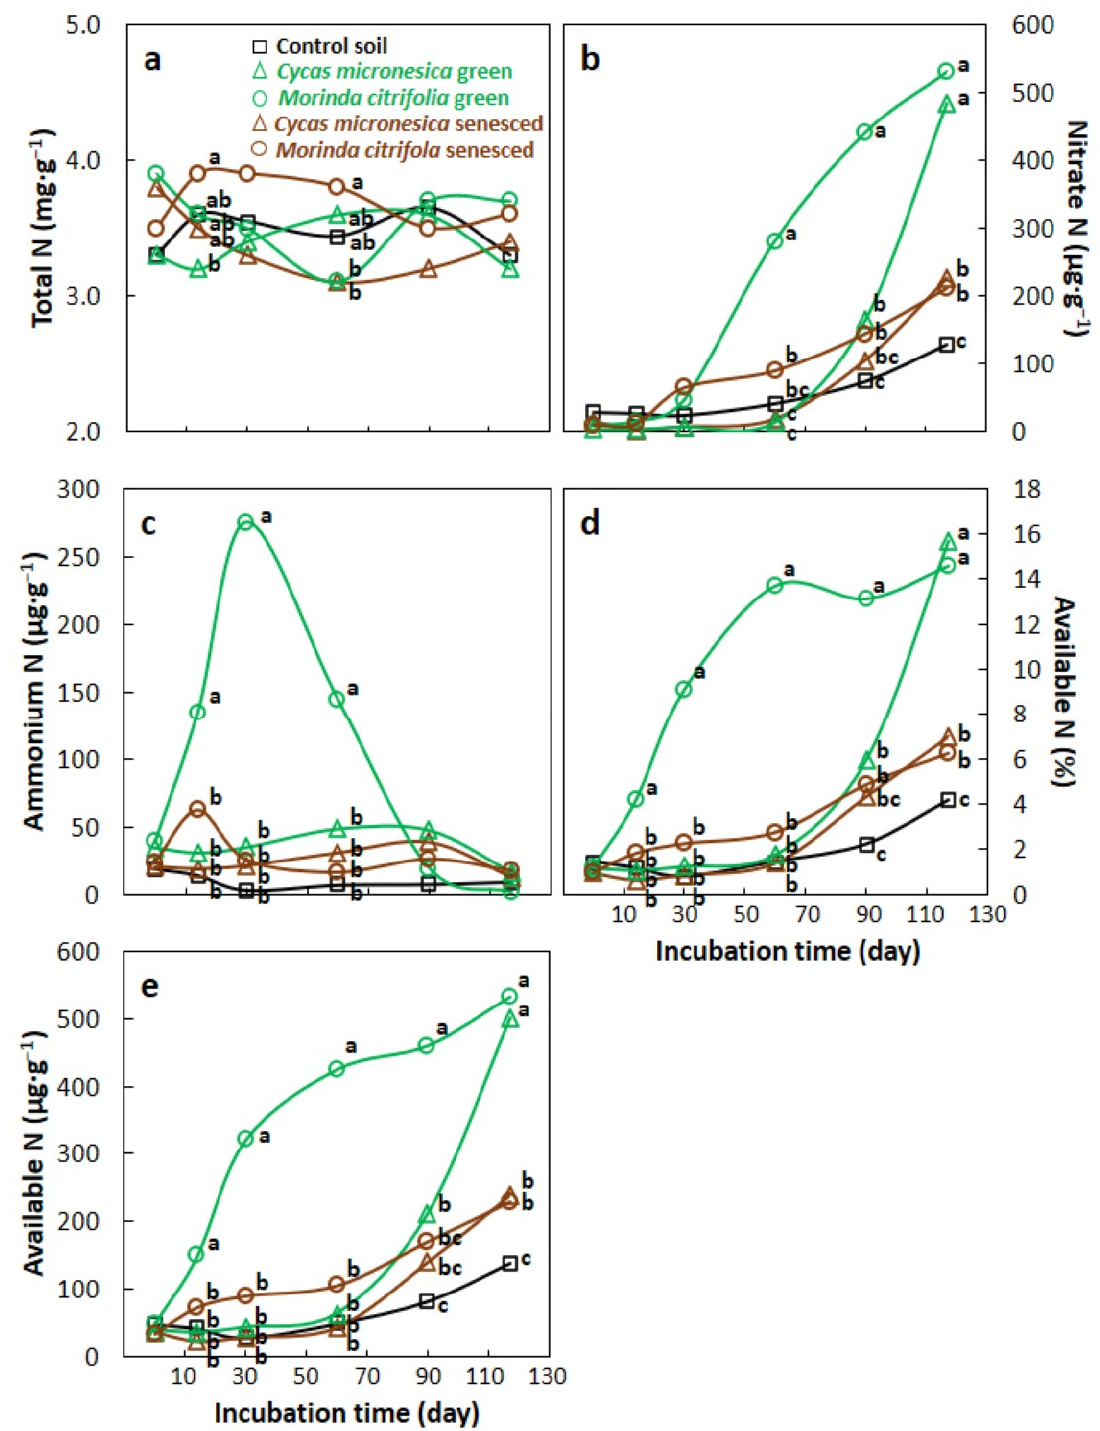
Figure 3. The influence of soil priming with Cycas micronesica or Morinda citrifolia leaf litter on changes in the nitrogen status over a 117-d incubation period. ( a ) Total N; ( b ) nitrate N; ( c ) ammonium N; ( d ) the percentage of total N comprised of available N; ( e ) available N. Means with same letter within each sampling date are not statistically different according to Tukey’s HSD. Dates with no letters indicate no differences among the soil treatment means.